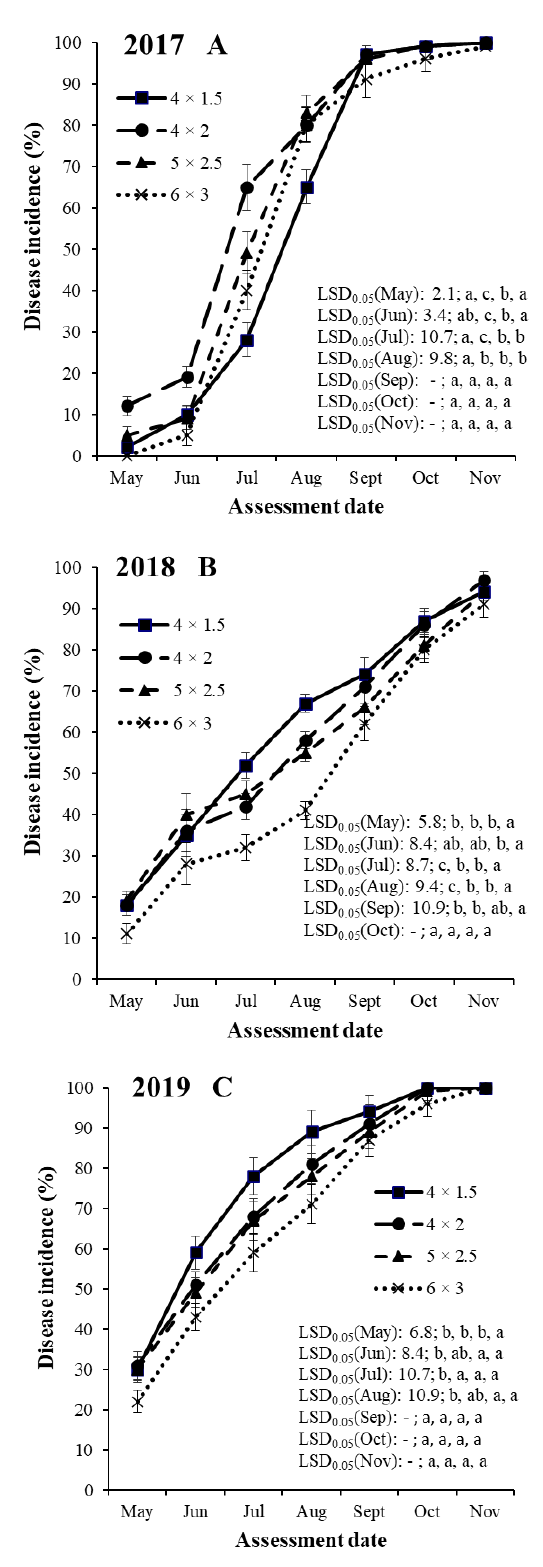
Figure 2. Temporal dynamics of shot hole incidence on plum cultivar ‘Bluefre’ in four training systems (4 × 1.5, 4 × 2, 5 × 2.5 and 6 × 3 m) in the years of 2017 ( A ), 2018 ( B ) and 2019 ( C ) at seven assessment dates (May, Jun, Jul, Aug, Sept, Oct and Nov) in an integrated plum orchard at Debrecen-Pallag, Eastern Hungary. Details of explanations on significant symbols and LSD-test are given in Figure 1.